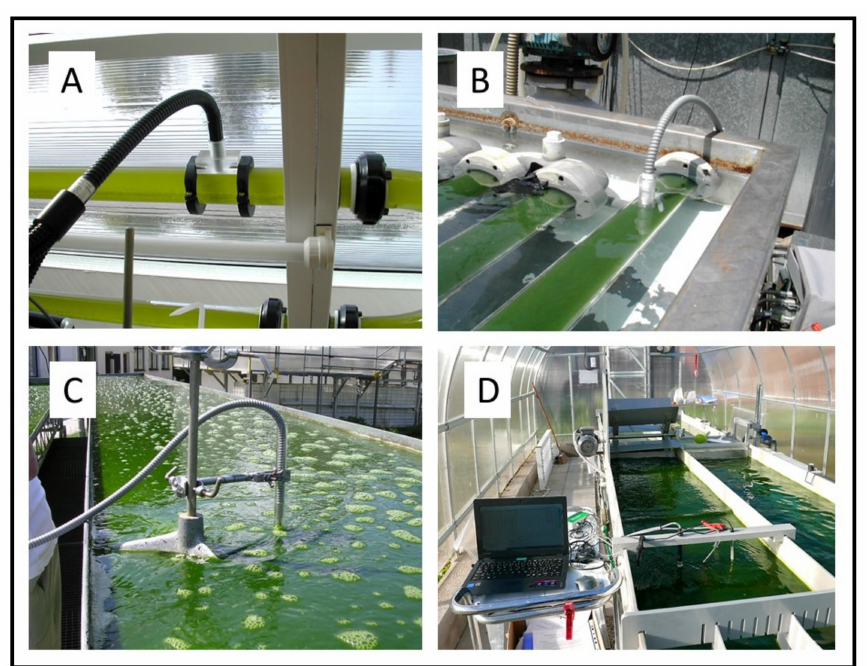
Figure 5. In-situ Chl fluorescence measurements in microalgae cultures using various PAM fluo- rimeters. ( A ) Tubular indoor PBR with Haematococcus , Institute of Physical Biology, University of South Bohemia, Nov é Hrady, Czech Republic; ( B ) tubular outdoor PBR with Arthrospira, Institute of Ecosystem Studies, CNR, Sesto Fiorentino, Italy; ( C ) outdoor thin-layer cascade with Chlorella , and ( D ) outdoor thin-layer raceway pond with Monoraphidium, both in Centre Algatech, Institute of Microbiology, Tˇreboˇn, Czech Republic. The fiber optics of the fluorimeter were placed on the wall of a PBR tube (panels ( A , B ), or were submerged directly in the culture using solar irradiance as actinic light (panel ( C )). Sensors of dissolved oxygen concentration, temperature, irradiance and Chl fluorescence were submerged in the culture side by side to measure data in parallel ( D